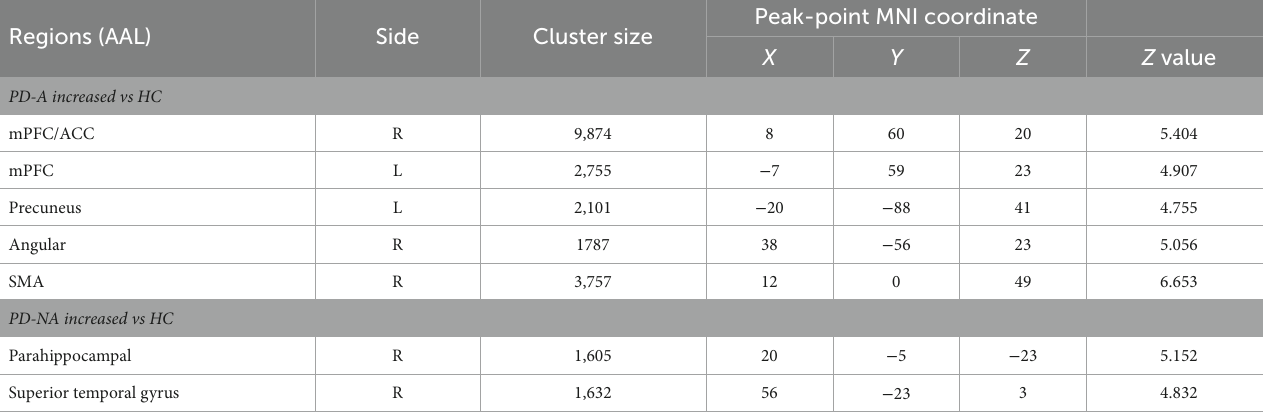
TABLE 2 Regions with QSM value differences between each two groups (voxel-wise p < 0.001 and cluster-wise FWE-corrected p < 0.05).